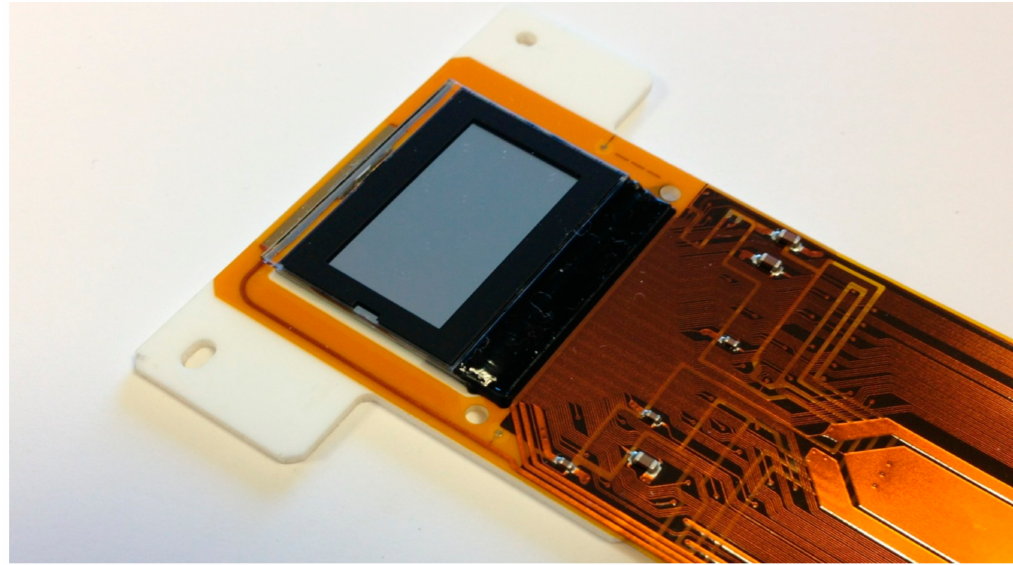
Figure 5. High performance, phase-only